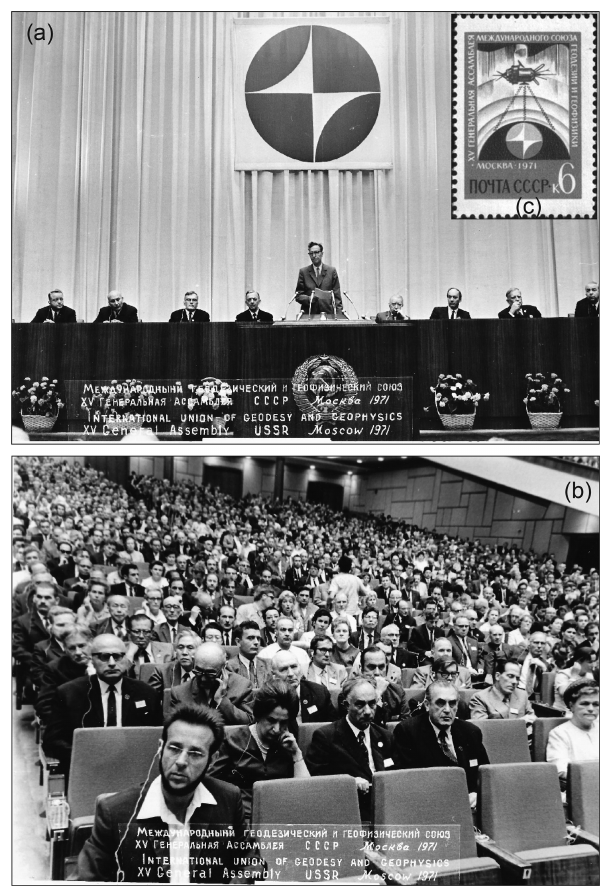
Figure 4. XV General Assembly in Moscow, USSR. (a) Open- ing ceremony and (b) delegates attending the ceremony in the Kremlin Congress Palace Hall (photos a and b : cour- tesy of Alik Ismail-Zadeh). (c) The USSR produced a stamp on the occasion of the IUGG General Assembly (photo: